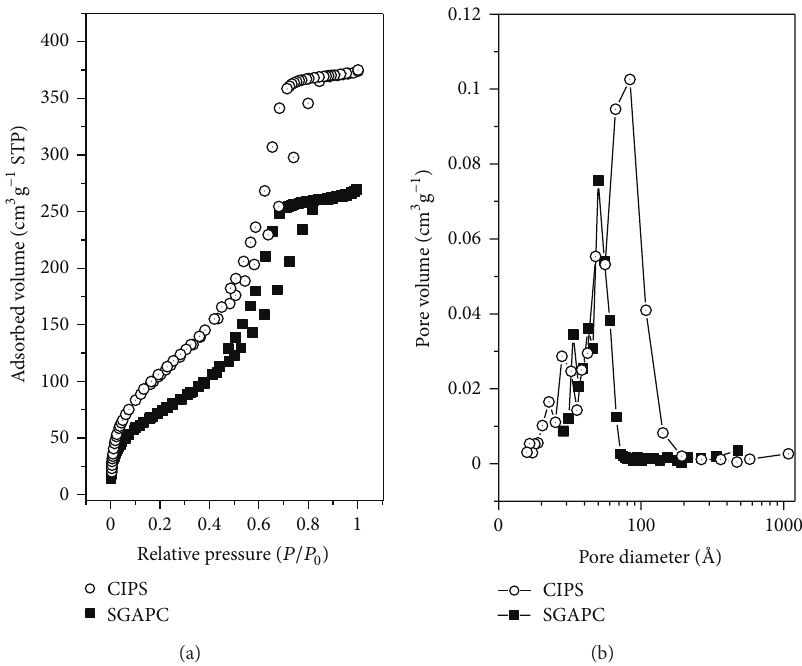
Figure 5: N 2 adsorption/desorption iso terms at 77 K (a) and pore size distributions (b) for ClPS and SGAPC.